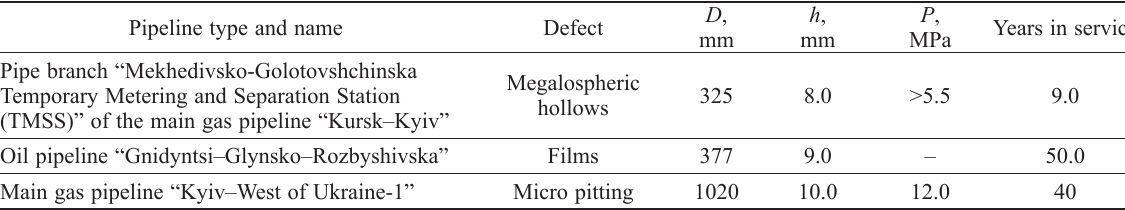
Table 1. Parameters of investigated sections of gas and oil pipelines